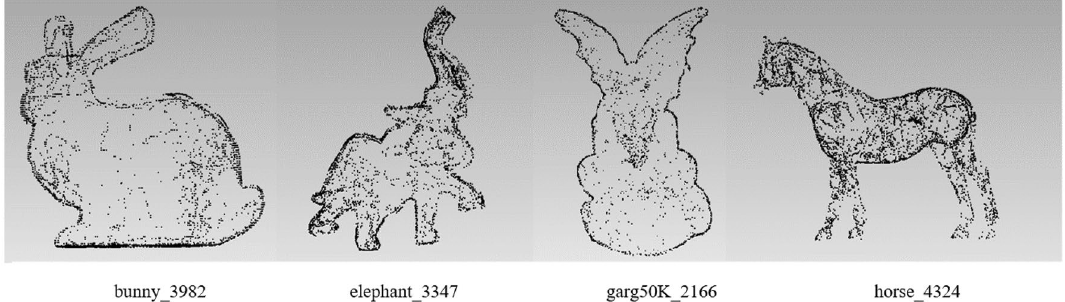
Figure 11. Feature points extraction results. The number of feature points of bunny = 3982, elephant = 3347, garg50K = 2166, and horse = 4324.